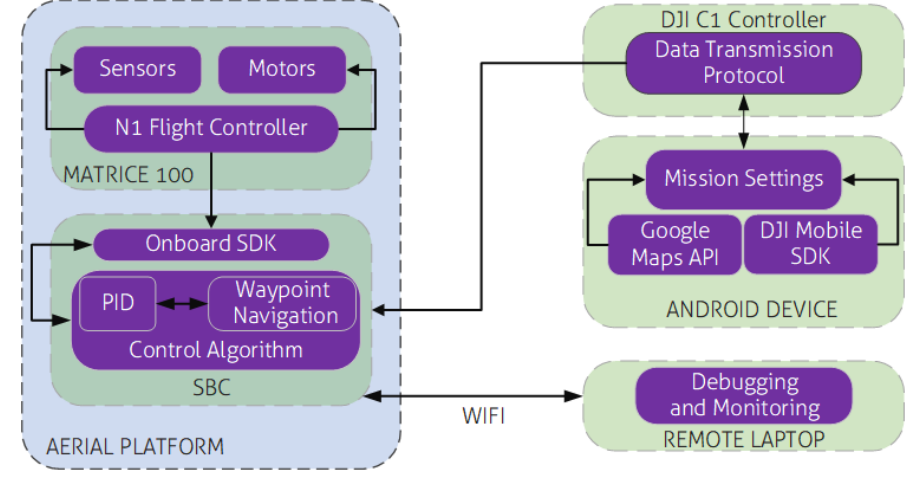
Figure 2. System Architecture of the